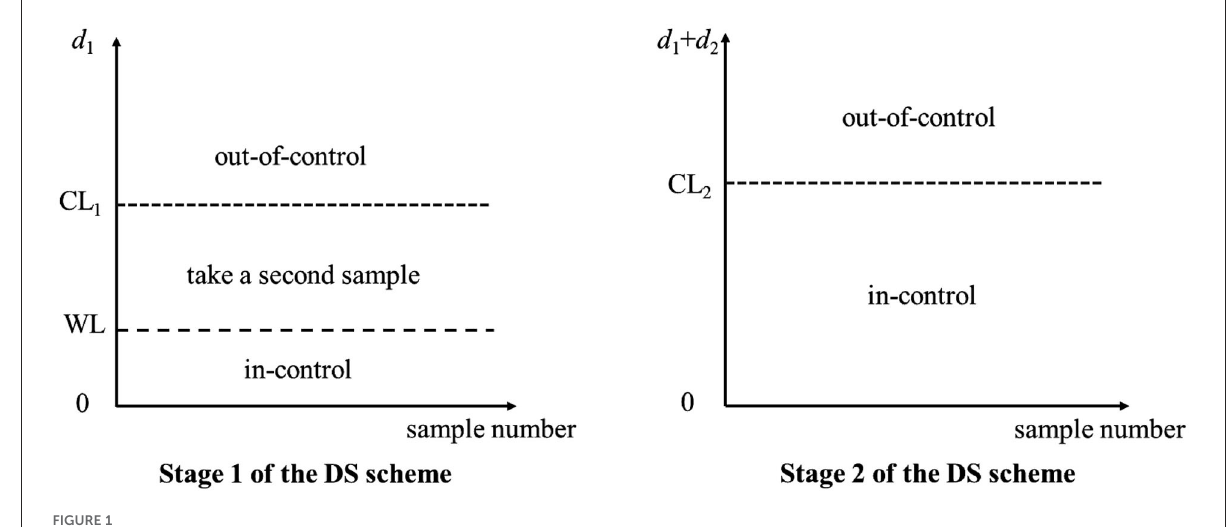
FIGURE1 Regions at stages 1 and 2 of the DS